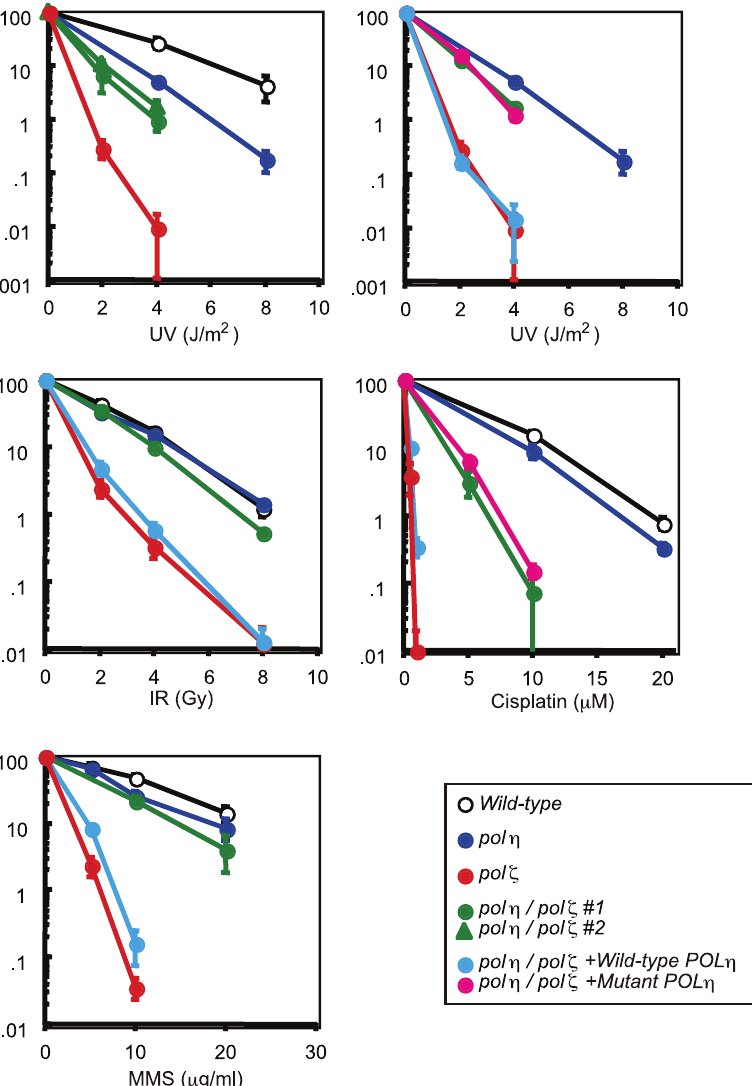
Figure 2. Increased tolerance of pol g /pol f cells to various genotoxic stresses, compared with pol f cells. Colony survival of the indicated genotypes following the indicated genotoxic stresses. Data for the pol g /pol f # 1 clone are shown in the other figures. Error bars show the SD of the mean for three independent assays. doi:10.1371/journal.pgen.1001151.g002 PLoS Genetics |